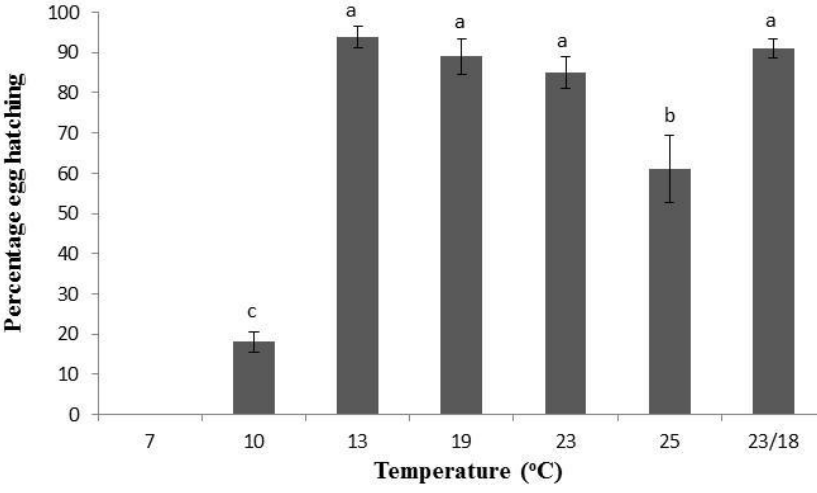
Figure 2. Percentage of Tuta absoluta eggs hatching at various temperatures (°C) . Different letters denotes significant differences ( p <